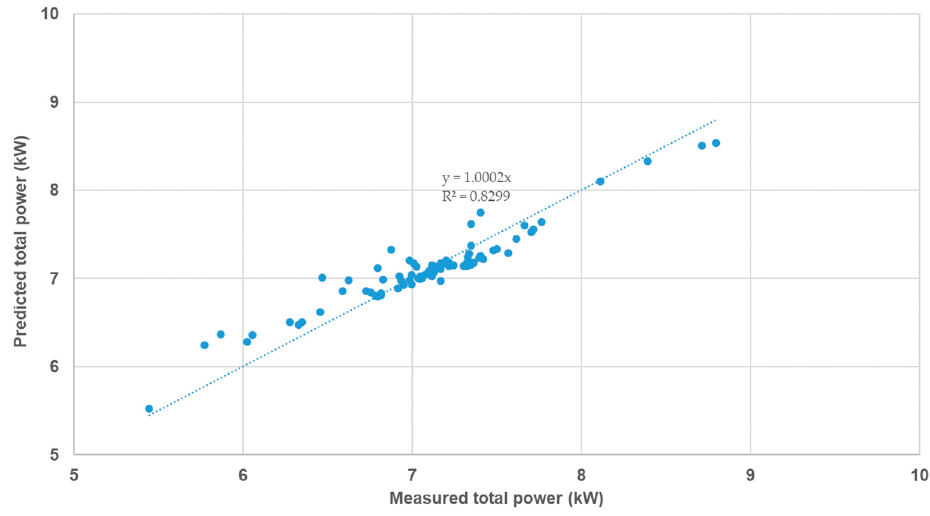
Figure 10. Comparison of predicted and measured power when the DPC is operating.